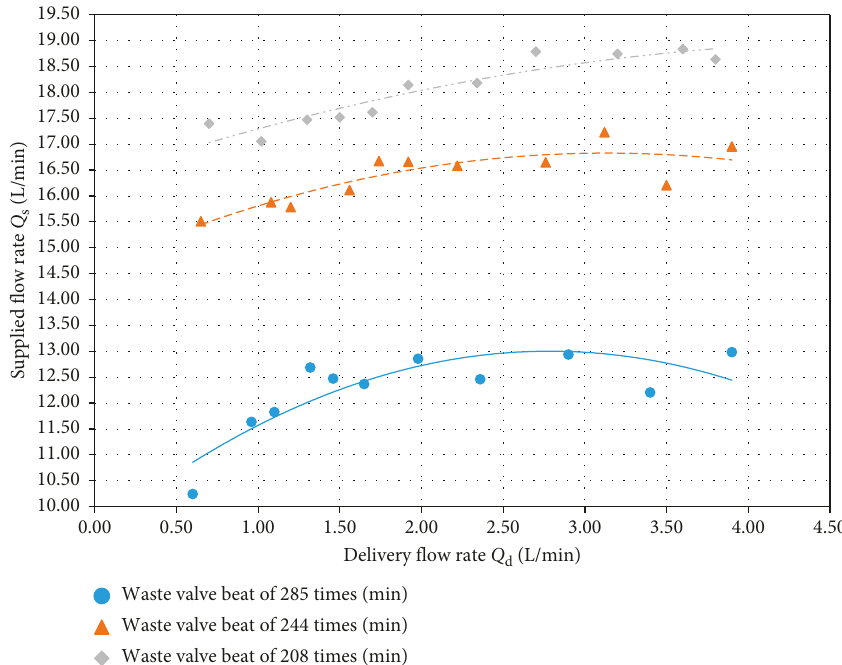
Figure 11: Supply flow rate vs. delivery flow rate at different waste valve beat rates, f